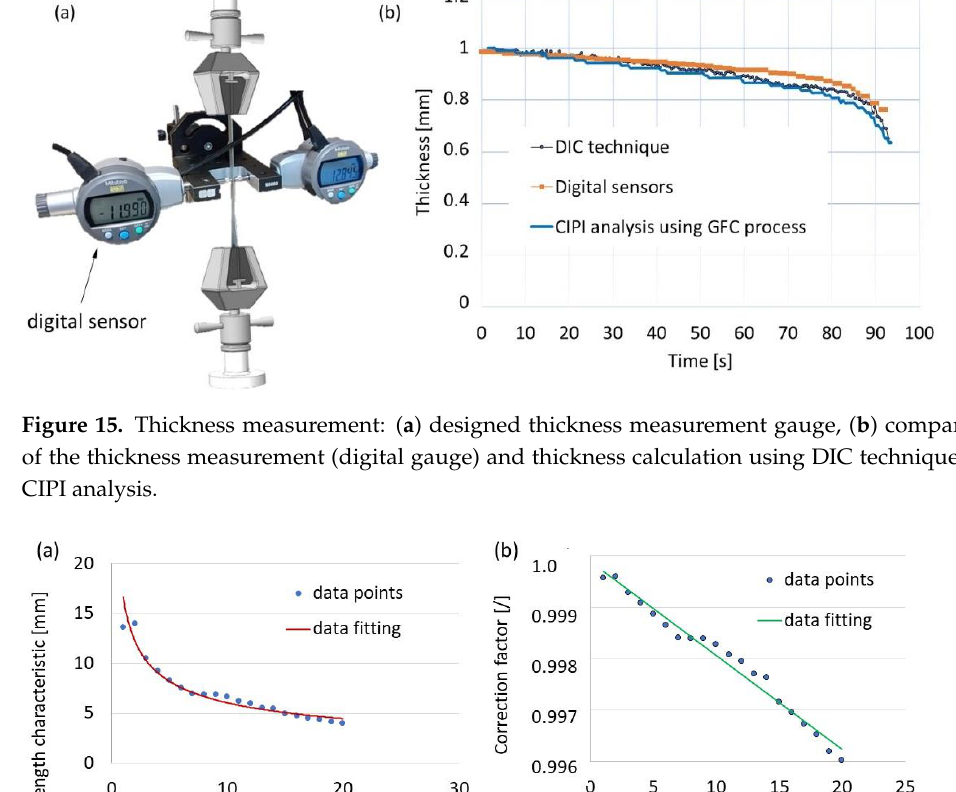
Figure 15. Thickness measurement: ( a ) designed thickness measurement gauge, ( b ) comparison of the thickness measurement (digital gauge) and thickness calculation using DIC technique and CIPI analysis.